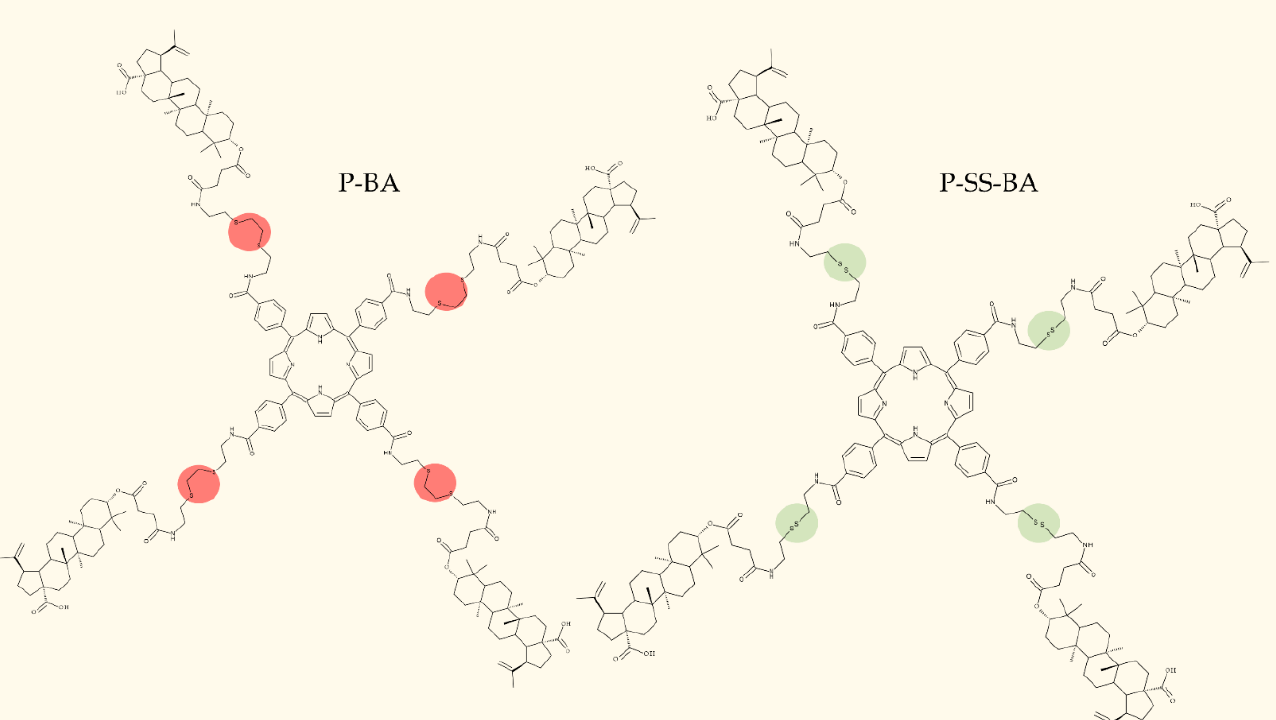
Figure 4. The chemical structure of P-BA and P-SS-BA (the red circle highlights the unbreakable bonds and the green circle highlights the breakable disulfide bonds in the given conditions).